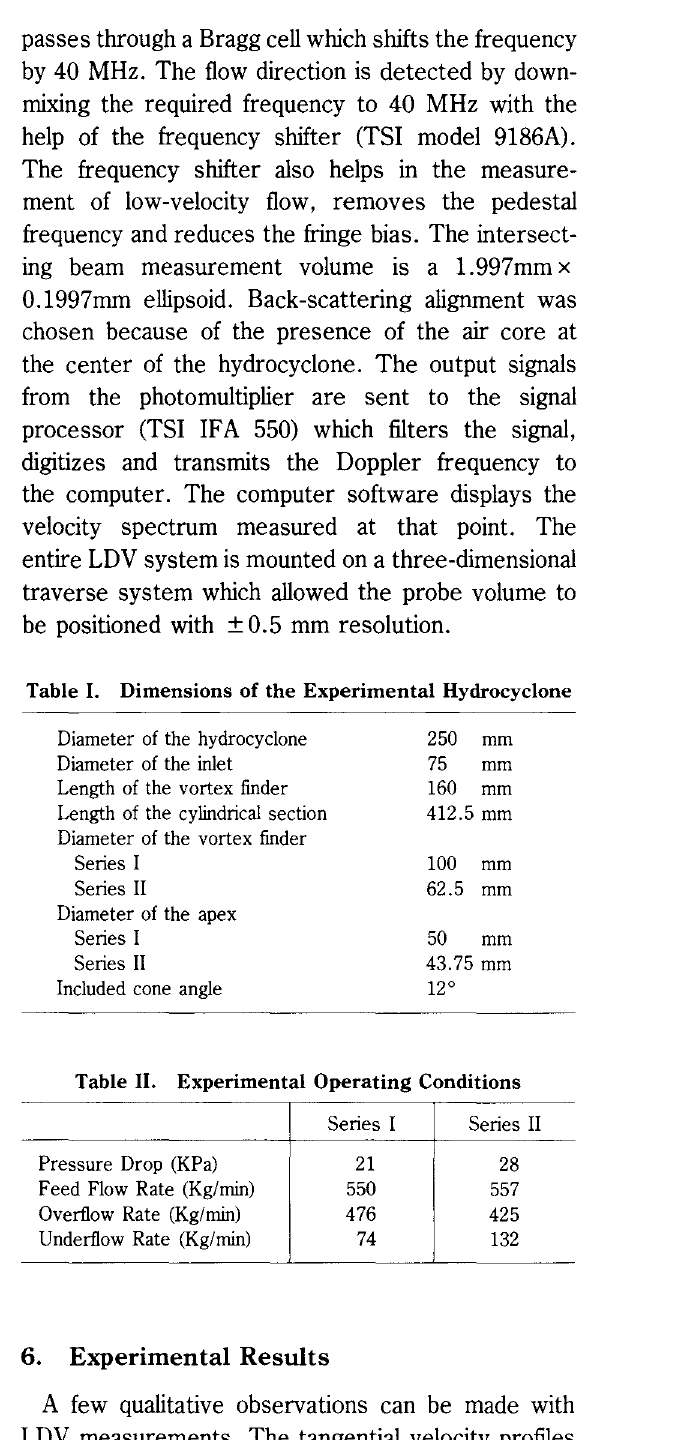
Table I. Dimensions of the Experimental Hydrocyclone Diameter of the hydrocyclone